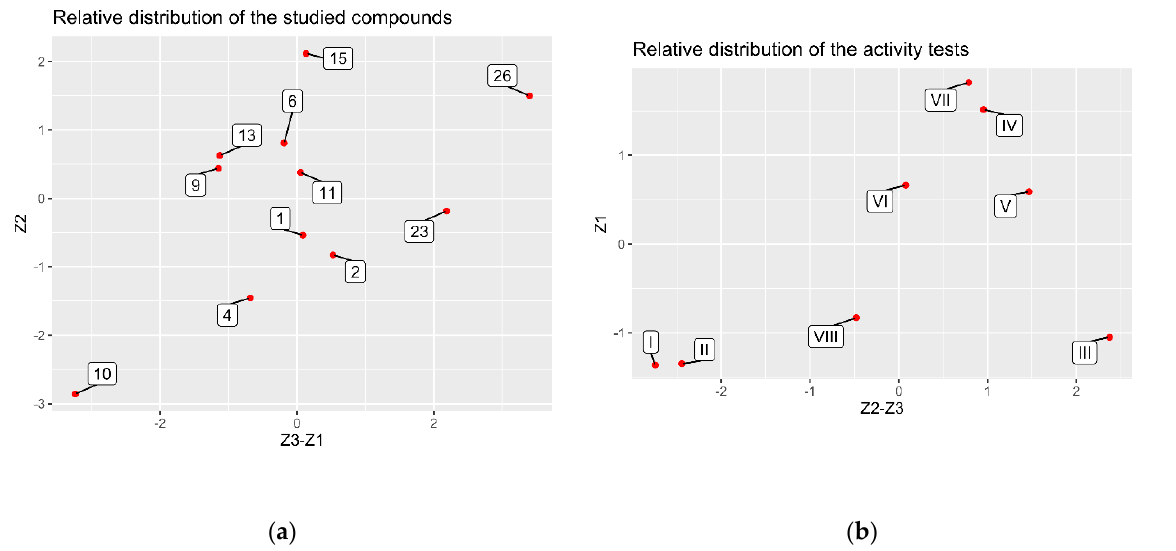
Figure 9. Linear maps of the selected compounds in the space of the first two principal components (subjected to VARIMAX rotation), regarding their relative compositions ( A ) and relative biological activities ( B ).